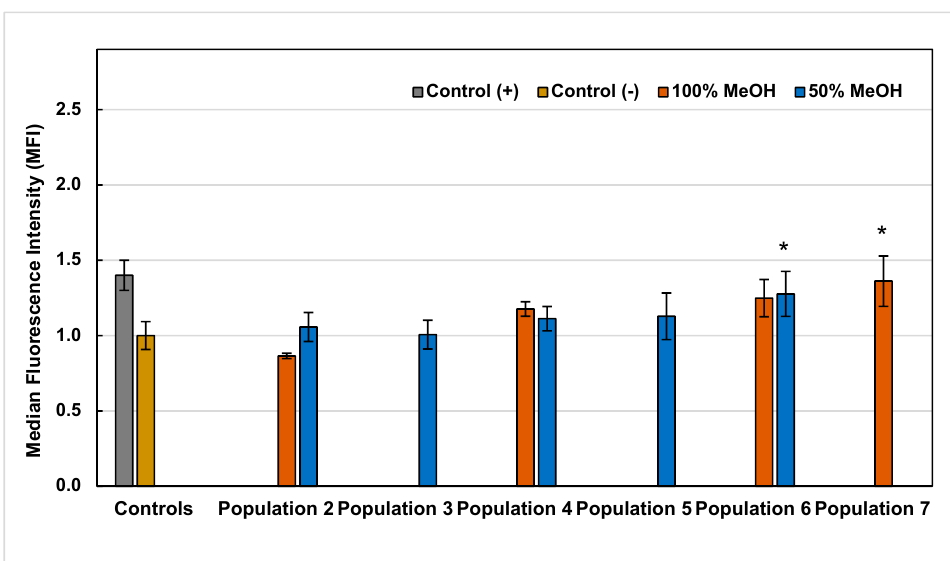
Figure 2. Intracellular ROS production values generated by the exposure of HL60 cells to 50% and 100% methanolic extracts of A. linaria after 1 h. Values are expressed as the mean ± standard deviation of three repetitions. (*) Indicates significant statistical difference from the control according to Dunnett's test ( p < 0.05), (**) p < 0.01.